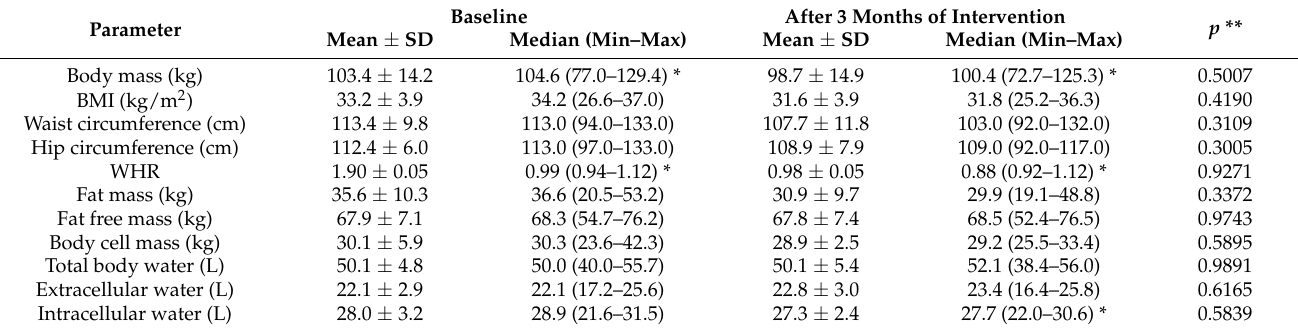
Table 3. The body mass and body composition of the male participants at baseline and after 3 months of intervention.